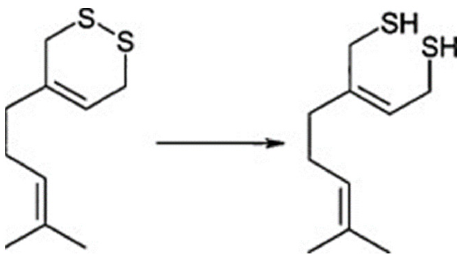
Figure 4. Thiol formation via opening of myrcene disulphide heterocyclic ring by the yeast reducing activity, from [44].